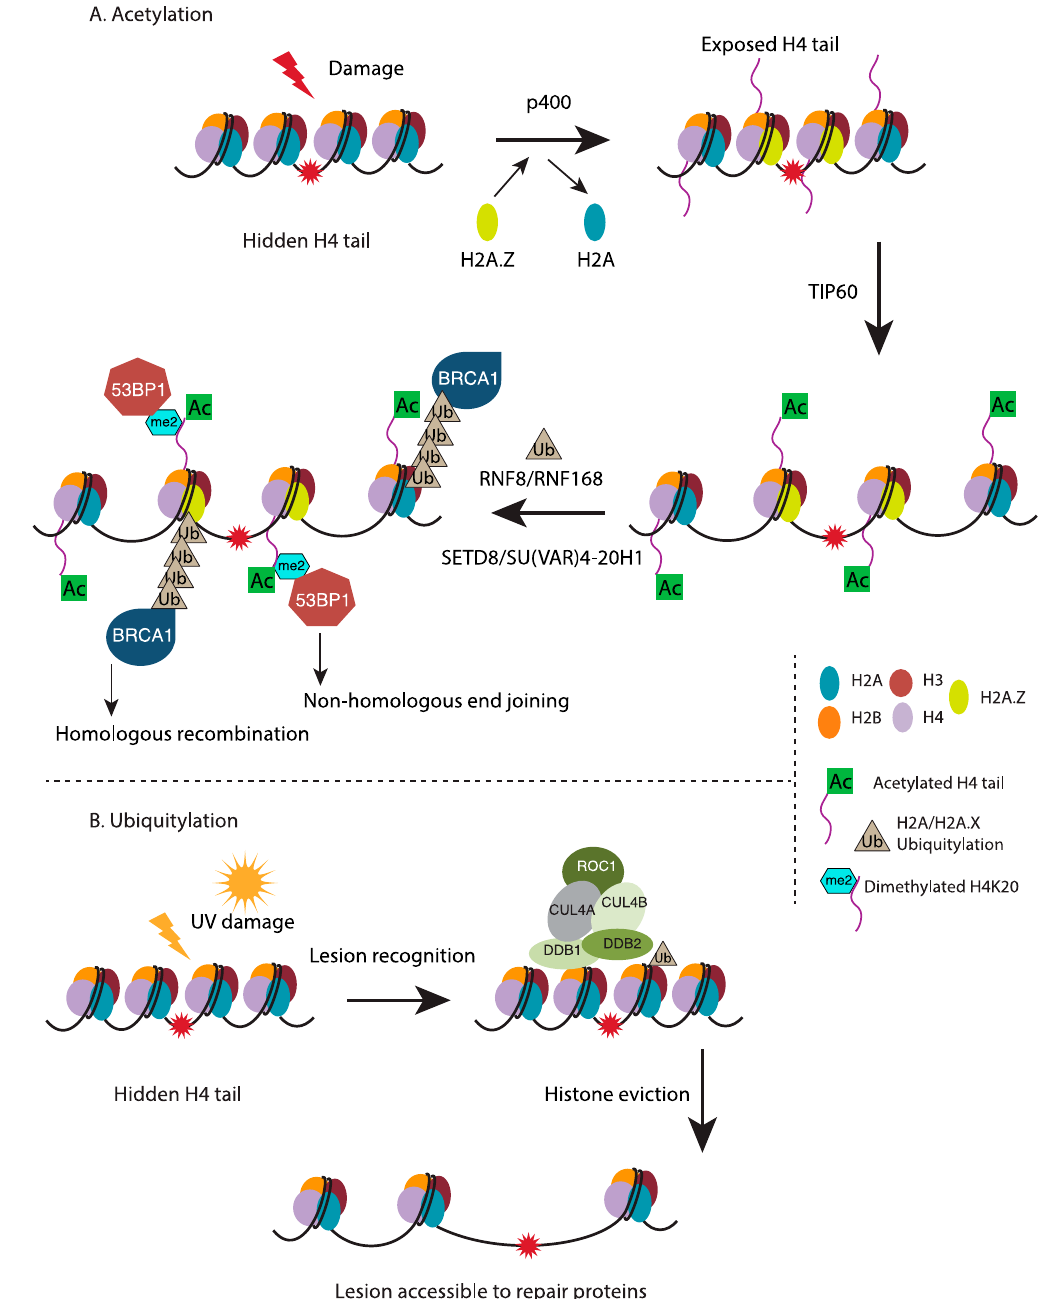
Figure 2. Chromatin structure is modified in response to DNA damage: ( A ) Acetylation: Following irradiation, p400 facilitates exchange of the histone variant H2A.Z in place of histone H2A to destabilize nucleosomes surrounding the DSB in turn exposing the histone H4 tail that can now be acetylated by the TIP60 histone acetyltransferase. H4 hyperacetylation further relaxes the chromatin structure and enables access to downstream repair factors. RNF8/RNF168-dependent histone ubiquitylation provides docking site for the HR-promoting BRCA1 complex. Alternatively, histone H4 lysine 20 dimethylation (affected by SU(VAR)4-20H1 that uses H4K20me1, catalyzed by SETD8, as substrate) is recognized by the NHEJ factor, 53BP1; ( B ) Ubiquitylation: Following UV-induced damage, NER lesion recognition elements are recruited to sites of damage where they function to facilitate ubiquitylation of histones H3 and H4 by the CUL4-DDB-ROC1 ubiquitin E3 ligase, leading to their eviction from the nucleosome. This release of histones H3 and H4 from nucleosomes at damage site leads to increased accessibility for downstream NER